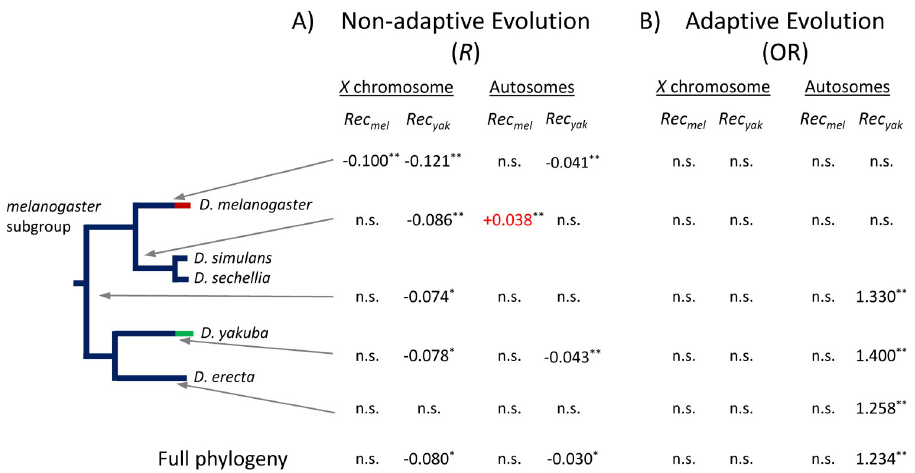
Fig 8. Correlation between rates of protein evolution and crossover rates in D . yakuba ( Rec yak ) or D . melanogaster ( Rec ). A) For each branch across the D . melanogaster subgroup phylogeny, estimates of the efficacy of selection on mel amino acid changes ( ω R ) per gene were compared to crossover rates, either Rec yak or Rec mel , with a generalized regression model (GRM) to estimate the correlation coefficient R . B) For each branch across the phylogeny, genes with and without signal of positive selection based on PAML (see text for details) were compared to crossover rates for these same genes. Odds Ratio (OR) from logistic regression analysis was applied to capture variable likelihood of positive selection with crossover rates (see text for details). Numbers in black indicate significant estimates of R in the direction predicted by models of selection and linkage whereas red numbers indicate a significant R in the opposite direction. � , P < 0.05; �� , P < 0.01; n.s., non-significant association ( P >